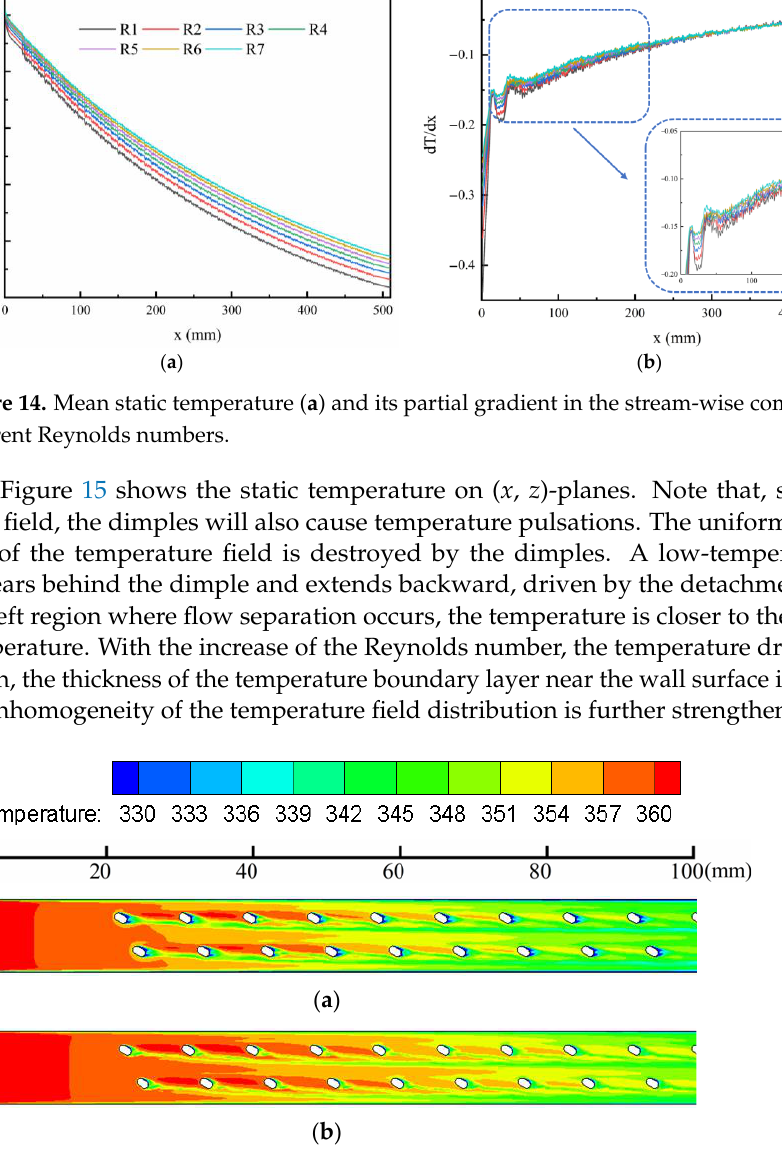
Figure 15. Static temperature on ( x , z )-planes at y / y 0 = 0.68 for R1 ( a ) and R7 ( b ) cases.